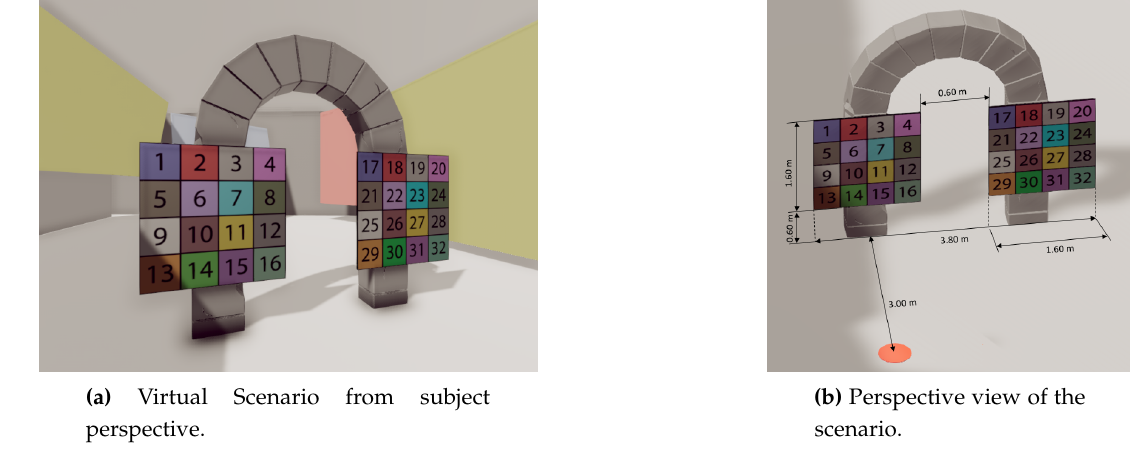
Figure 2. Virtual scenario screenshots. The orange dot (b) designates the position of the